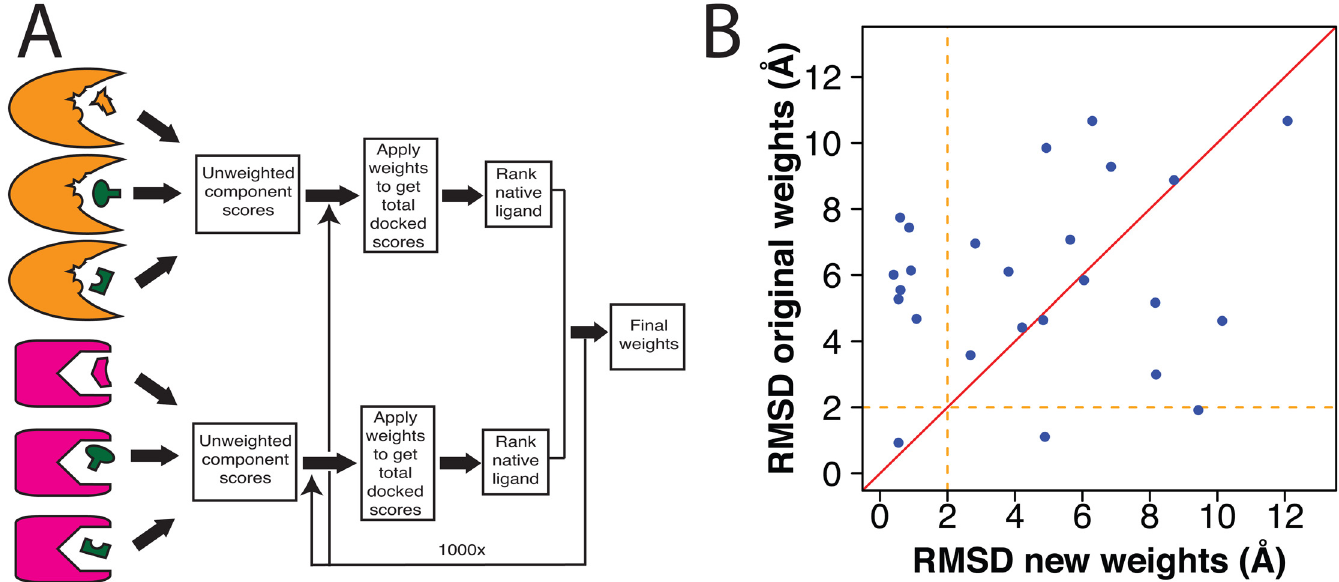
Fig 3. Updated weight-fitting strategy. (A) Schematic illustrating the strategy used in DARC 2.0 for determining values of the weights that should be applied to the terms in the DARC scoring function (Eq 1). For each complex used in training (S1 Table), we generate a large set of docked complexes involving either the cognate “ native ” ligand ( orange/magenta ) or one of many “ decoy ” ligands ( green ). Using the component energies in these complexes, we identify the set of weights that optimally ranks the native ligands ahead of the “ decoys ” . (B) For each protein-ligand complex in our set, we used DARC to dock the ligand back into its cognate receptor using either the original DARC weights or the newer weights derived though the approach described here. In the latter case, leave-one-out cross-validation was used to ensure the weights were not overfit to the training set. Each point represents a separate complex; points above the diagonal are those for which the new weights led to better pose